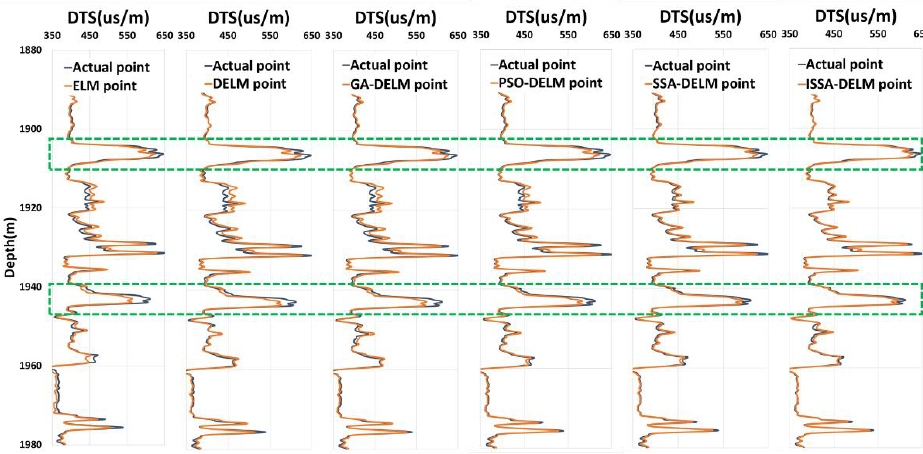
Figure 8. Visual results of the RHOB prediction results of the Well N. The cross-plots of original DTS vs. predicted DTS using ISSA-DELM, SSA-DELM, PSO-DELM, GA-DELM, DELM, and ELM in Well N are shown in Figure 9. It can be observed that the predicted results of ISSA-DELM are closer to the original DTS than other models, indicating that the ISSA-DELM is better than other models in fitting multiple local details of DTS.